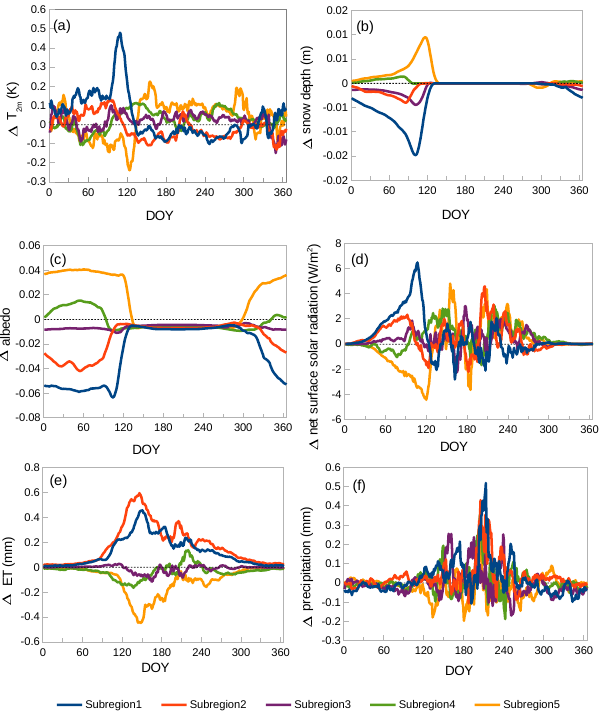
Figure 5. The 15-year averaged regional mean differences (FNFI10 – FNFI1) in 11-day running mean of daily mean (a) 2m air temper- ature, (b) snow depth (presented as equivalent water), (c) surface albedo, (d) net surface solar radiation, (e) ET and (f) precipitation of the five 15- year averaged regional mean differences (FNFI10 – FNFI1) in 11 day running Figure 5. The mean of daily mean ( a ) two-metre air temperature, ( b ) snow depth (presented as equivalent water), ( c ) surface albedo, ( d ) net surface solar radiation, ( e ) ET and ( f ) precipitation of the five subregions.